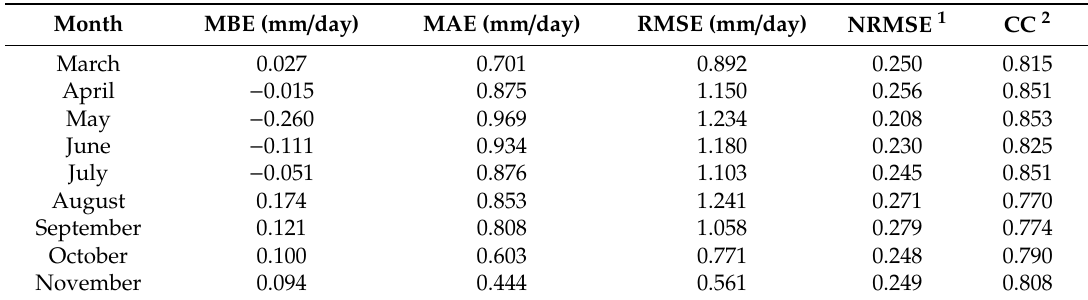
Table 7. Accuracy statistics of the ML-based ET 0 model in the croplands in South Korea, according to